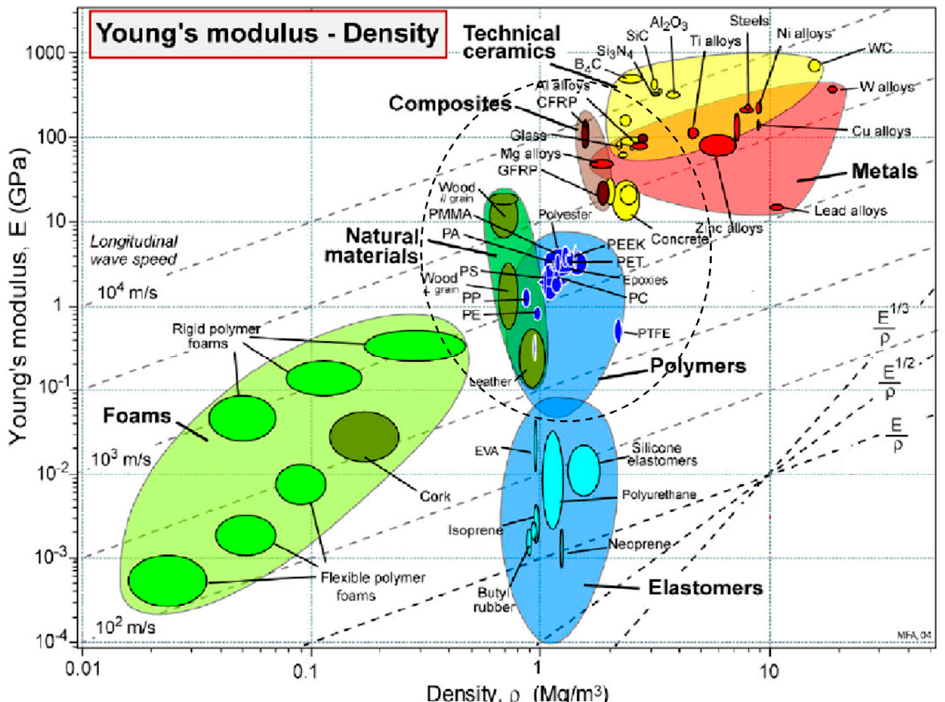
Figure 3. Wind turbine blade materials [33].